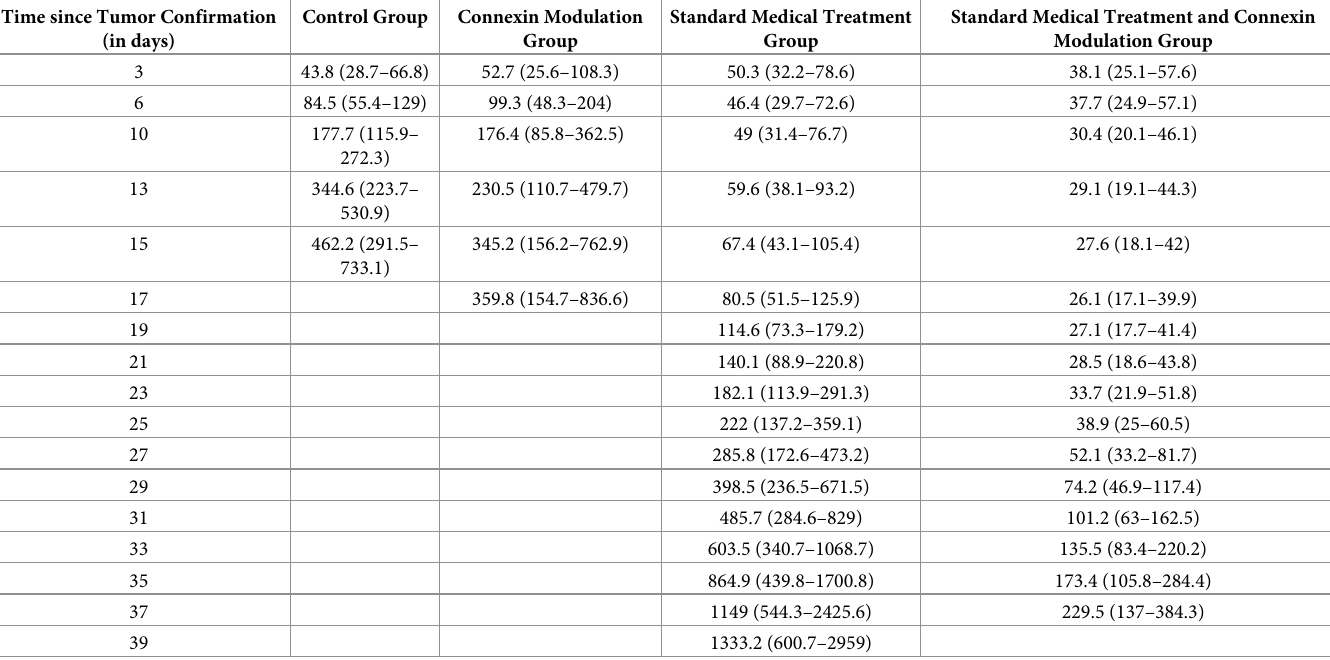
Table 1. Overview of estimated geometric mean tumor volumes.